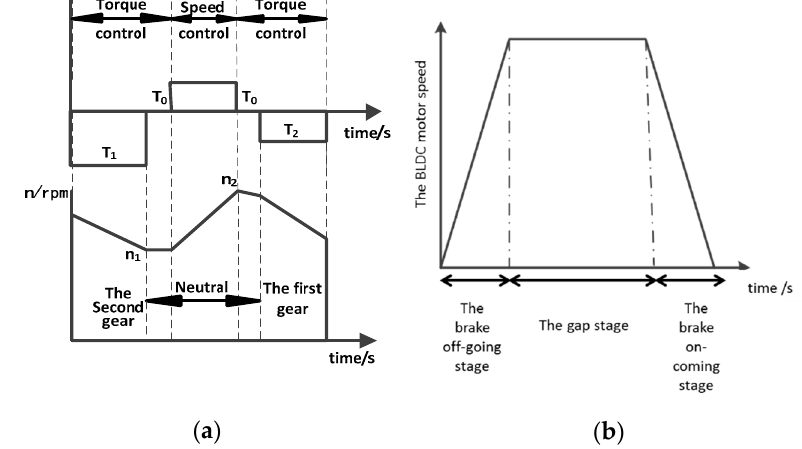
Figure 4. Ideal curve. ( a ) States of the driving motor; ( b ) States of the brushless DC (BLDC) motor.